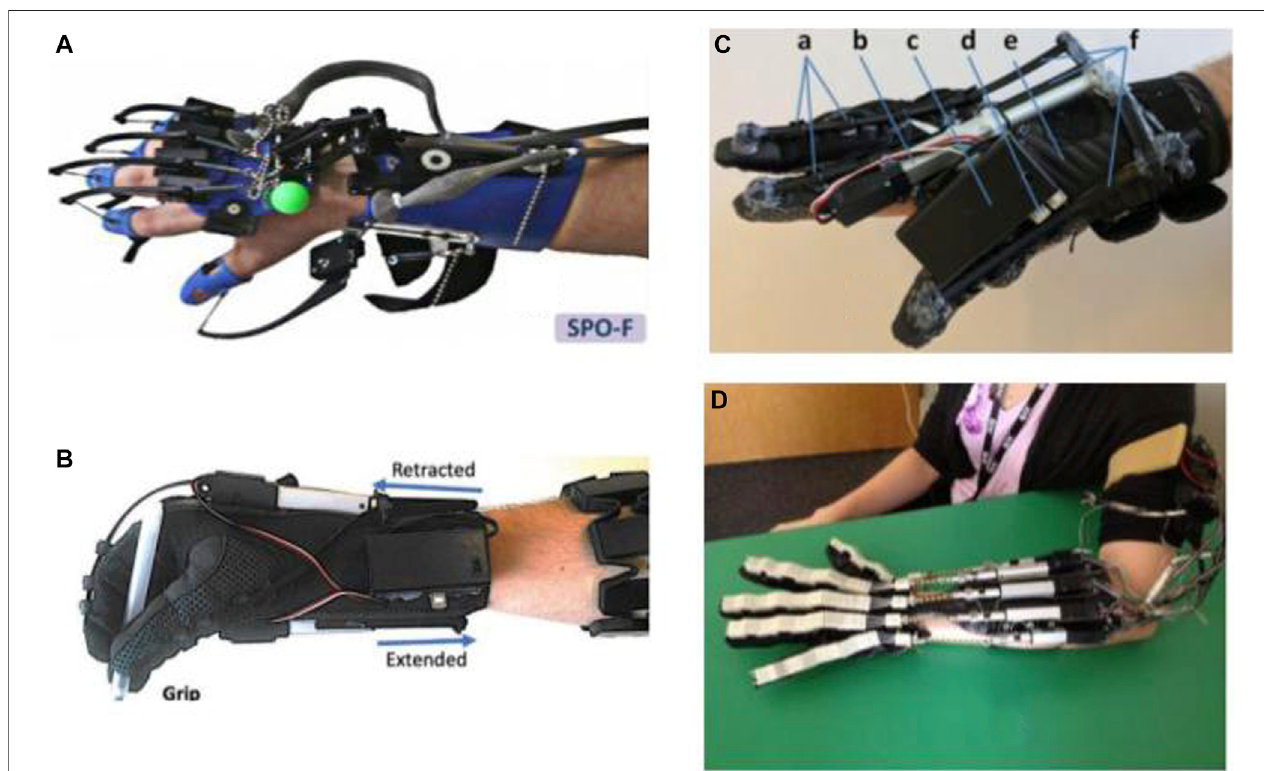
FIGURE 1 | Robotic gloves and exoskeleton devices for home-based hand rehabilitation: (A) SCRIPT project (Ates et al., 2017), (B) My-HERO (Yurkewich et al., 2020), (C) HERO (Yurkewich et al., 2019), and (D) X-Glove (Trianda fi lou, 2014).